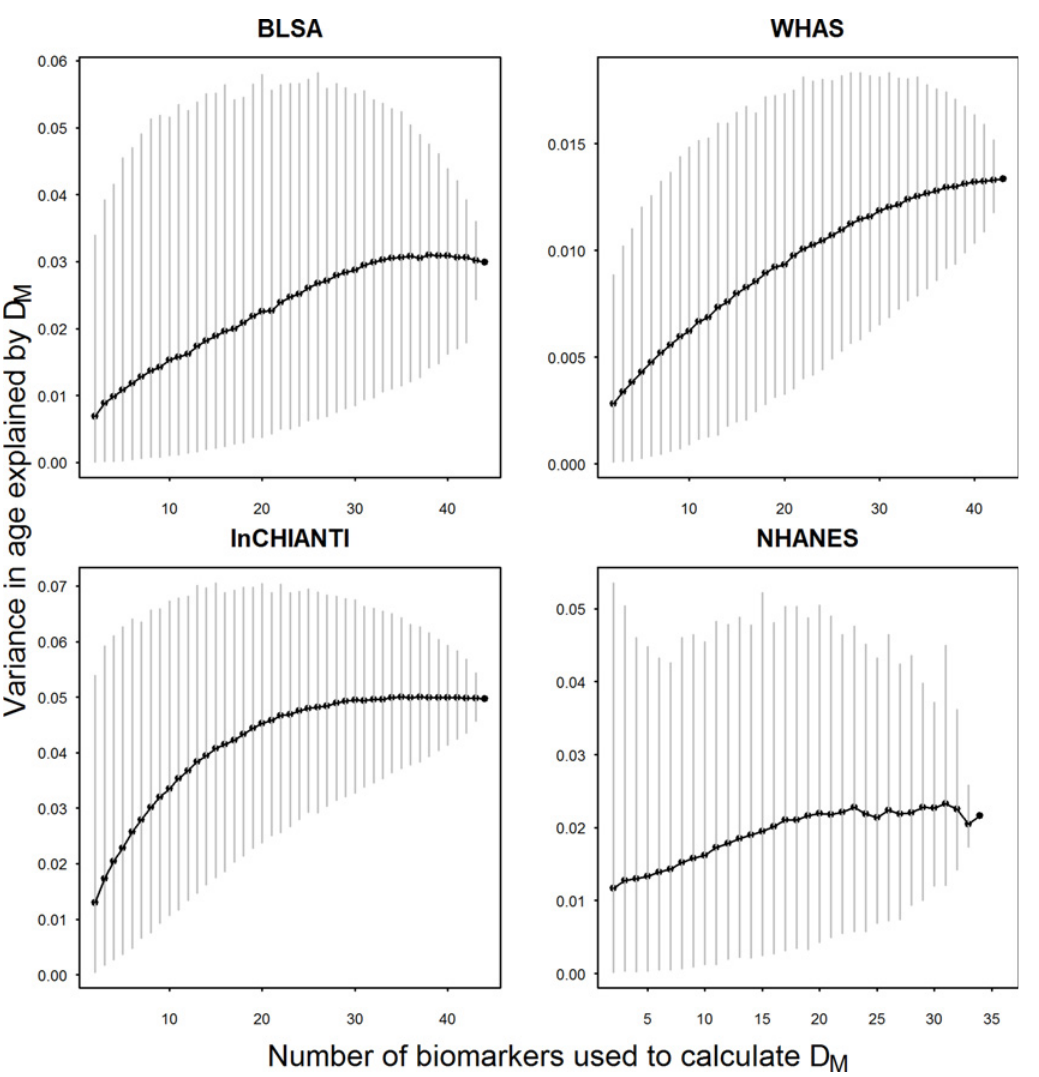
Fig 3. Mean variance of predicted D M values with age as a function of biomarker number. Grey vertical bars indicate 2.5 to 97.5 percentiles of observed variances in age explained by D M calculated from ~5,000 random combinations generated from a pool of 44 markers.